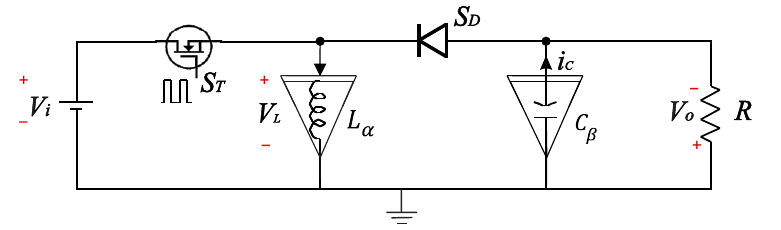
Figure 1. Fractional-order Buck-Boost